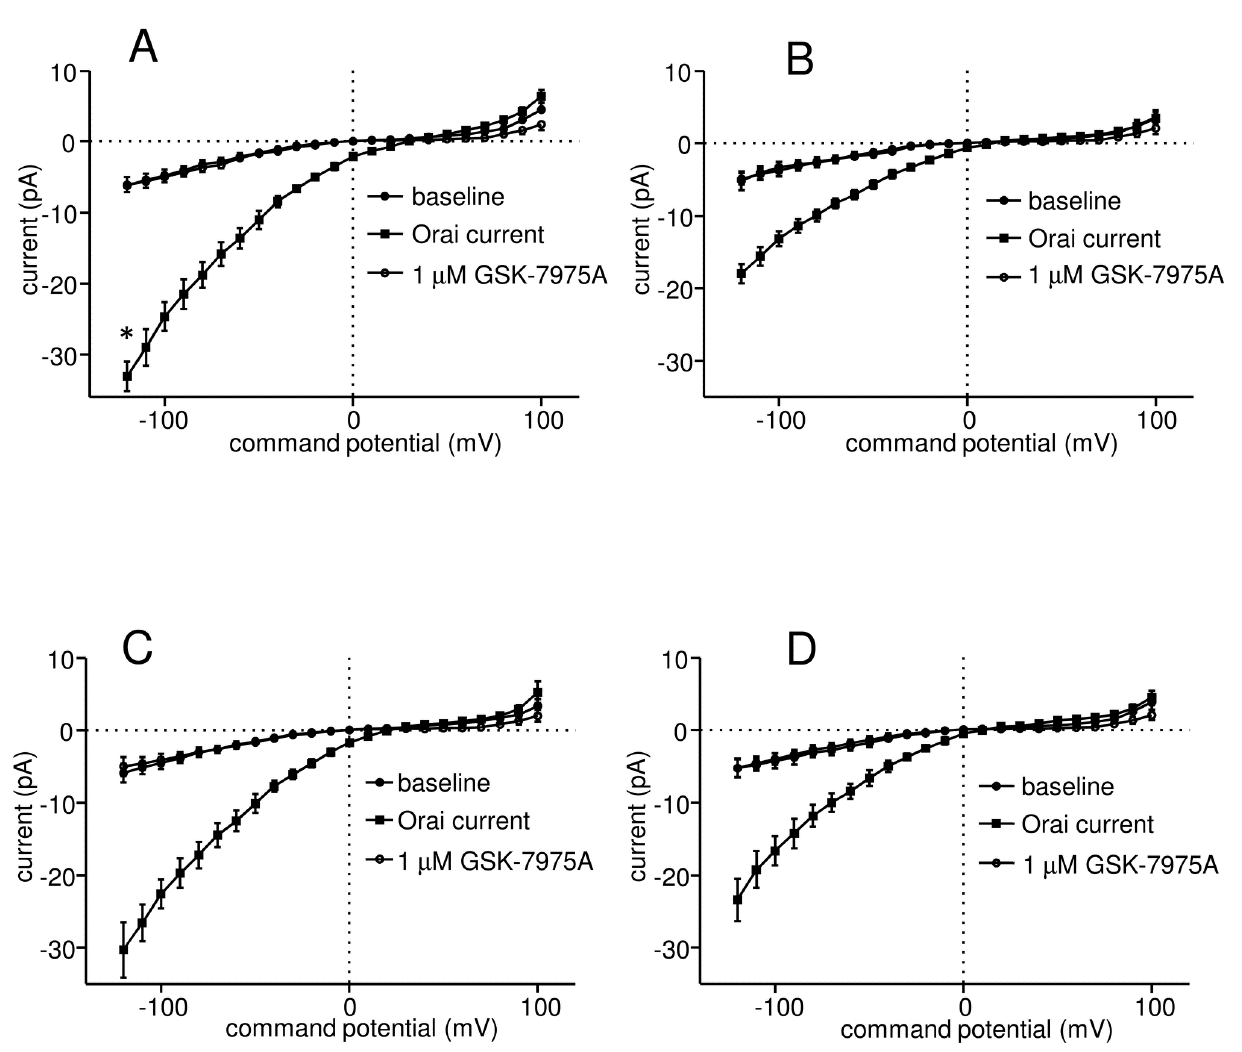
Figure 2. Knockdown of Orai1 but not Orai2 significantly reduces Ca 2+ influx in activated HLMCs. Whole cell patch clamp current-voltage (I–V) curves from HLMCs transduced with recombinant adenoviruses expressing (A) shRNA against luciferase (n=19 cells), or ( B ) against Orai1 (n=13); and ( C ) shRNA against luciferase (n=11) or against Orai2 n=14 ( D ). (●) baseline current, (■) current elicited following dialysis of HLMCs with 30 µM IP for 4 min, (○) current following the addition of 1 µM GSK-7975A. 3 Currents were recorded in 2 mM external Ca 2+ and are shown as mean ± SEM. *p=0.0292 compared with corresponding curve in ( B ). doi: